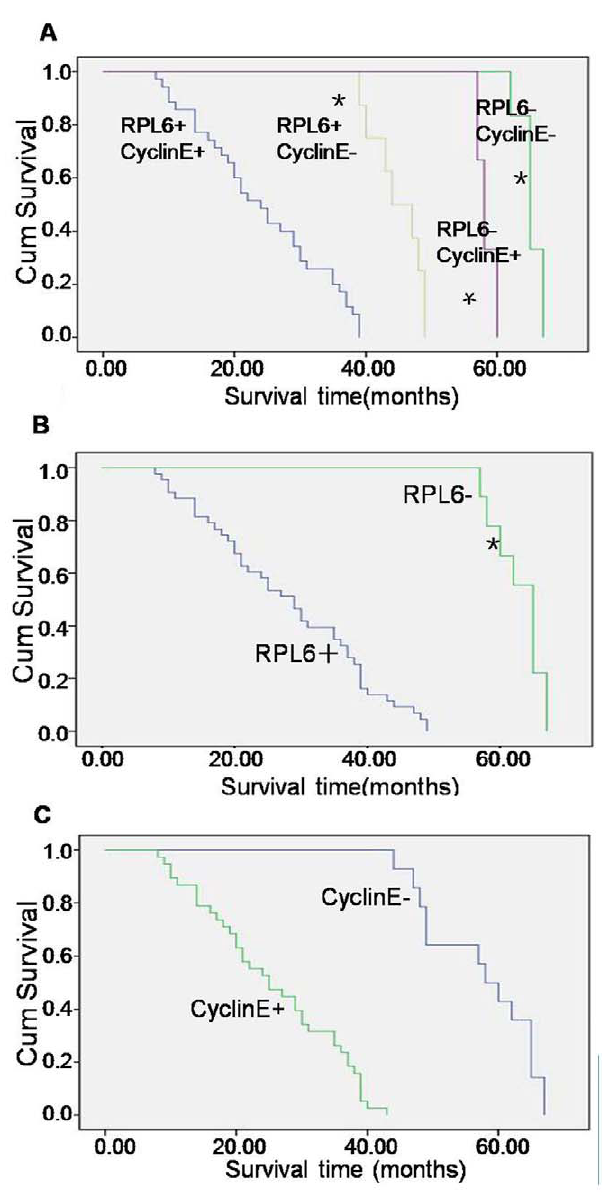
Figure 2. Upregulation of RPL6 and Cyclin E expression shorten patients’ survival time after followed up. A. Patients with both RPL6 and Cyclin E positive, RPL6 positive and Cyclin E negative, RPL6 negative and Cyclin E positive, both RPL6 and Cyclin E negative. B. Patients with RPL6 positive and negative. C. Patients with Cyclin E positive and negative. p , 0.01 vs both RPL6 and Cyclin E positive and the corresponding control; * p , 0.01 vs RPL6 positive and RPL6 negative.